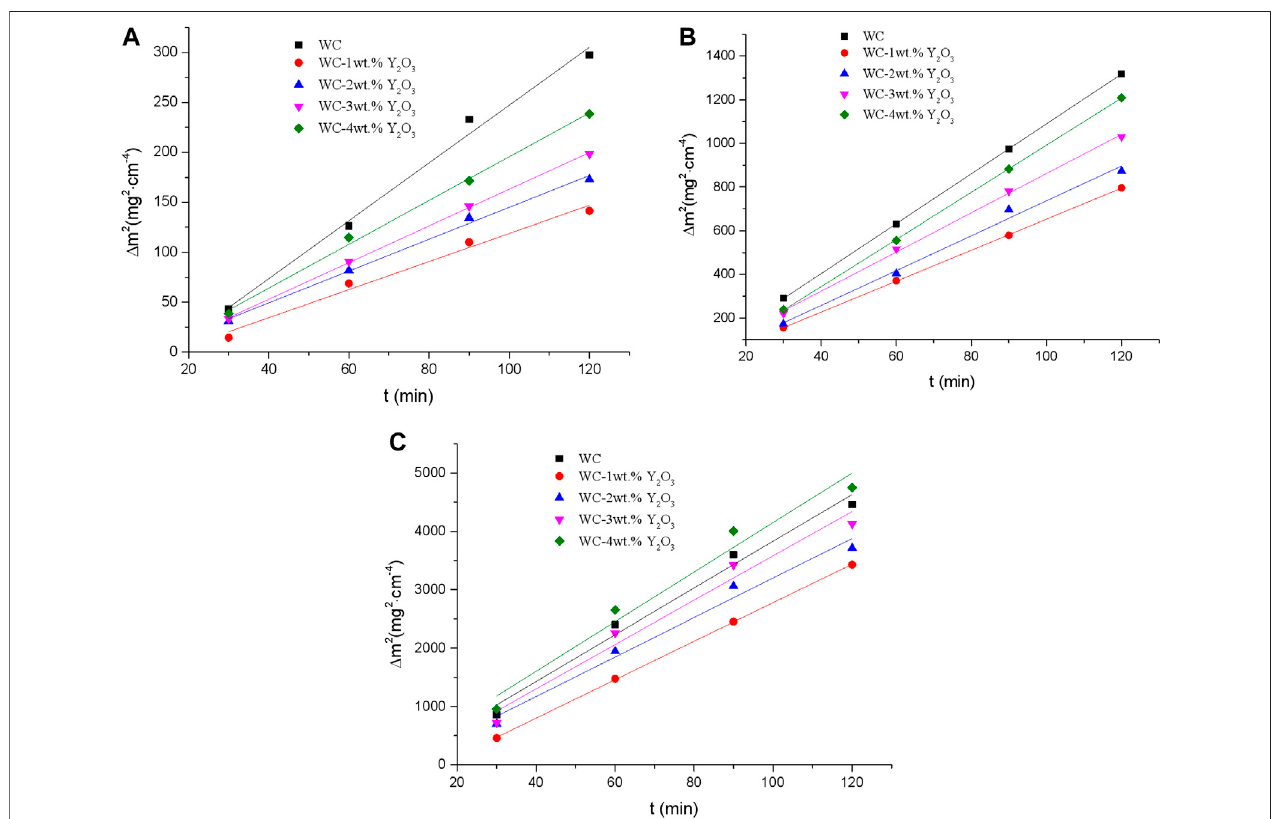
FIGURE 2 | Square of oxidation weight gain of binderless tungsten carbide vs. time at different oxidation temperatures. (A) 700 ° C; (B) 750 ° C; (C) 800 ° C.